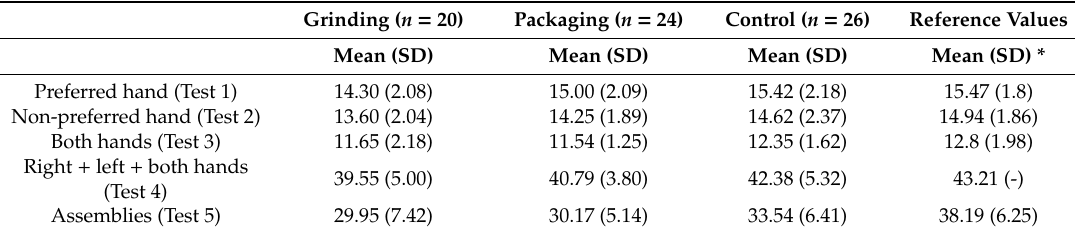
Table 11. Results of the Purdue Pegboard Test (in